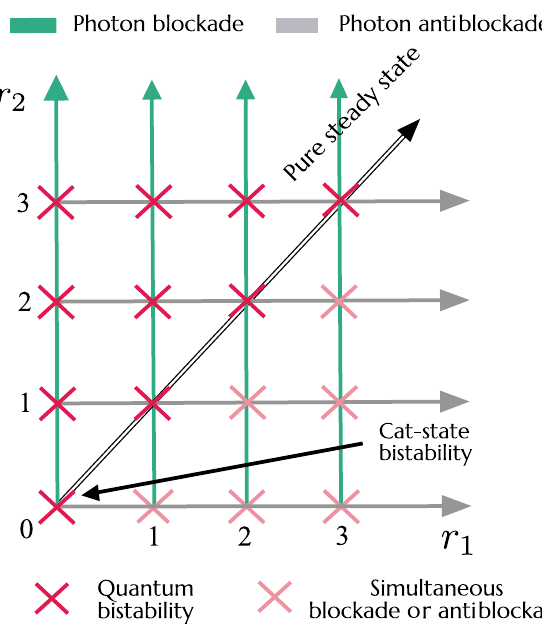
FIG. 3. Steady-state phase diagram for the generalized driven-dissipative Kerr resonator. r 2 is a dimensionless detuning parameter, whereas r 1 is a drive-dependent dimensionless param- eter; both are defined in Eqs. (39) and (40). The phase diagram indicates parameter choices that lead to unusual steady states (as we discuss in the main